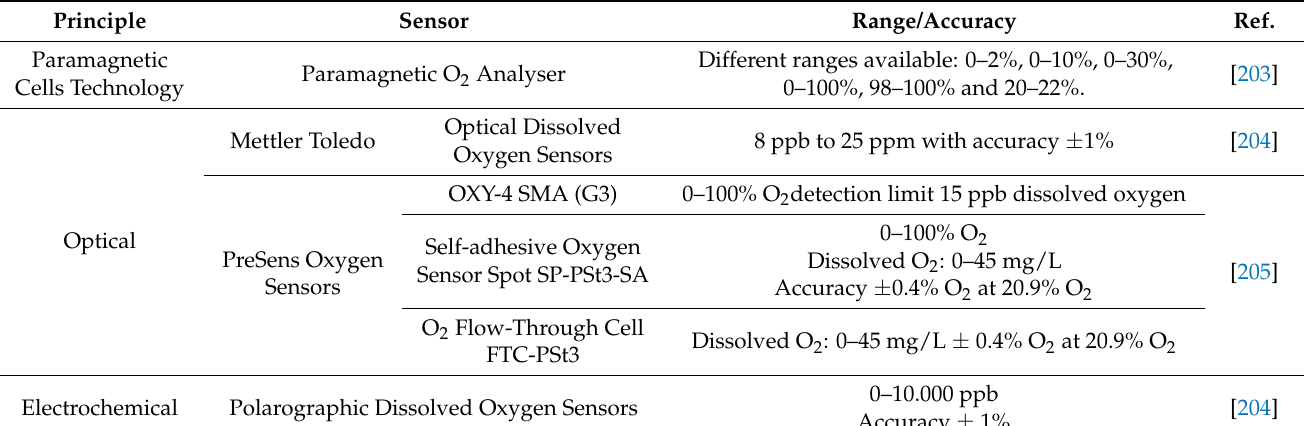
Table 4. Commercially available oxygen